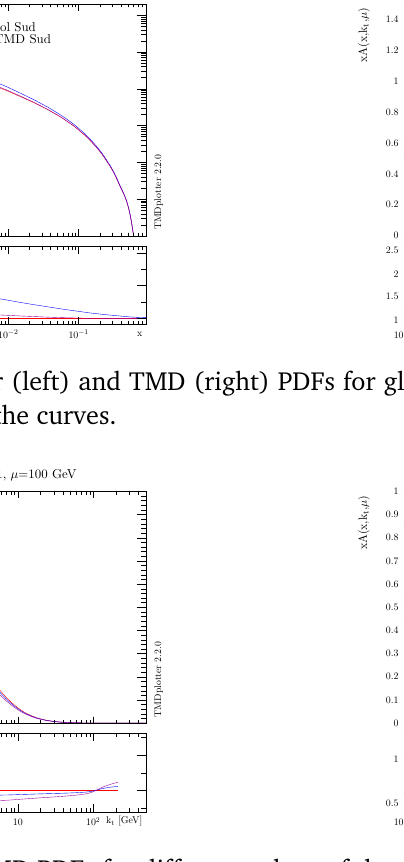
Figure 2: Gluon TMD PDFs for different values of the non-perturbative input q q . The bottom plots show the ratio between the s